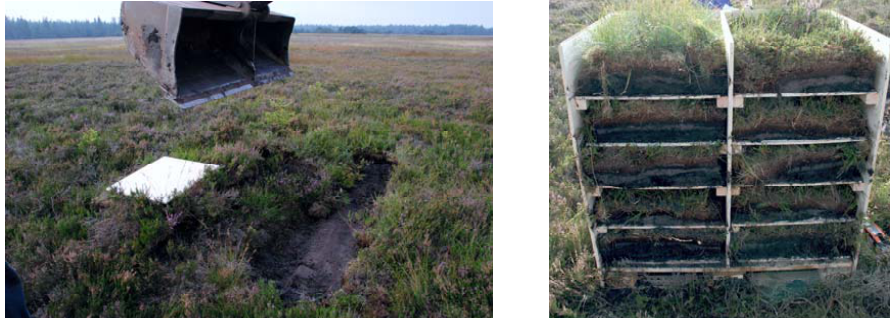
Figure 1. Photo ( left ) as well as detailed ( middle ) and simplified ( right ) scheme of vegetation–soil profile as encountered at the HOBE site in the Gludsted heathland, Denmark, and reinstalled at the Selhausen remote sensing field laboratory in Germany, on top of the sandbox surface covered with a wire grid.